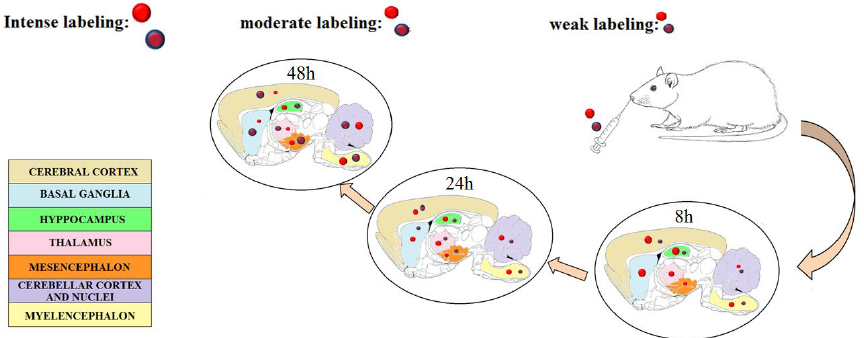
Figure 1. A scheme illustrating the localization of positive (red balls with blue ring) and negative (red balls) surface charged polymeric nanoparticles after IN administration in different brain regions (ex-vivo study in rats) at different times. The size of the balls indicates the intensity of fluorescence on the area by visual observation. [71] (By Bonaccorso et al., 2017) Reprinted with permission of